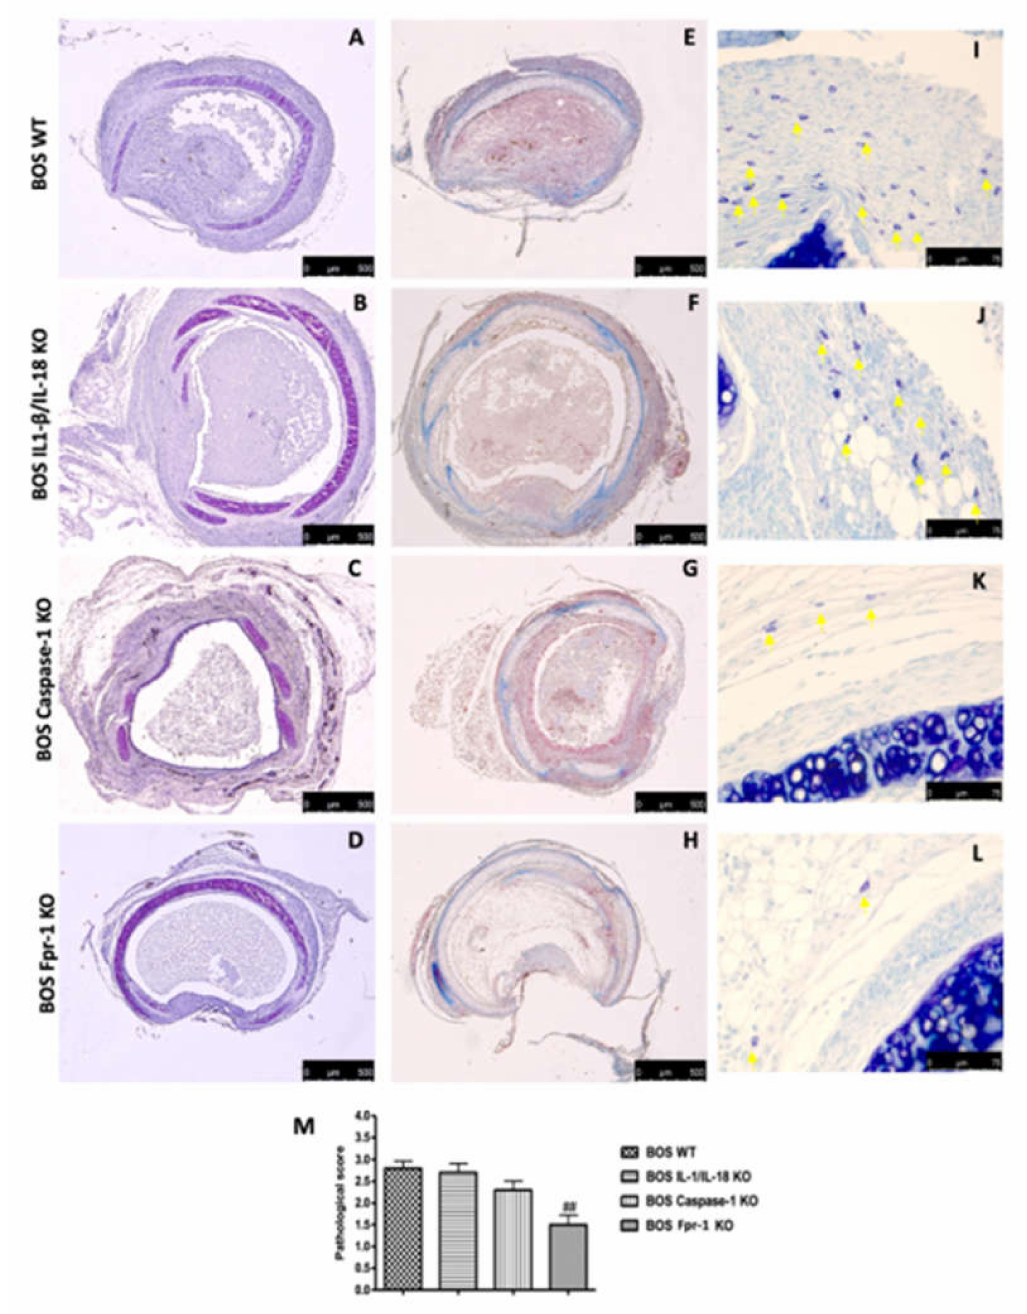
Figure 1. Histopatology evaluation and mast cell density in IL-1 β / IL-18 KO, Casp-1 KO, and Fpr-1 KO: Histological evaluation of tracheal transplantation: wild-type (WT) ( A ), IL-1 β / IL-18 KO ( B ), Casp-1 KO ( C ), Fpr-1 KO ( D ). Masson trichrome staining of the graft: WT ( E ), IL-1 β / IL-18 KO ( F ), Casp-1 KO ( G ), Fpr-1 KO ( H ). Evaluation of mast cell degranulation by toluidine blue: WT ( I ), IL-1 β / IL-18 KO ( J ), Casp-1 KO ( K ), Fpr-1 KO ( L ). Histopathologic score ( M ). For histological analyses, n = 5 animals from each group were employed. A p -value less than 0.05 was considered significant. ## p < 0.01 versus the WT